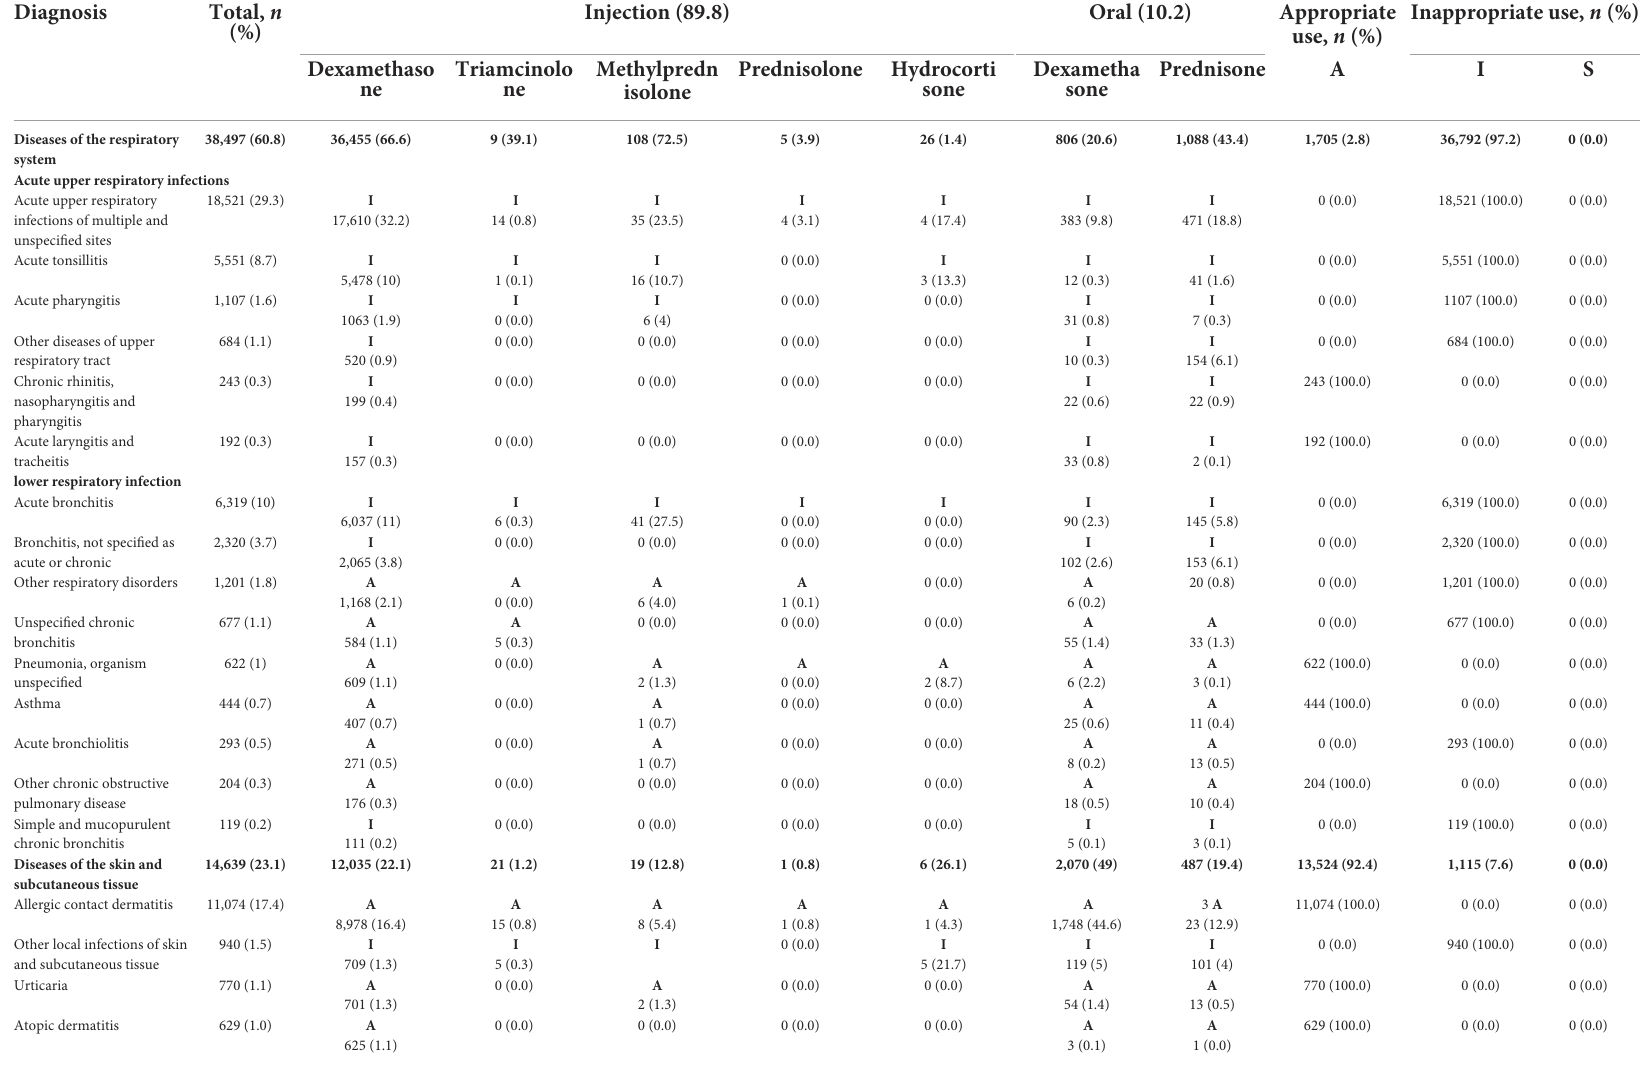
TABLE 1 Prescribing patterns and appropriateness of systemic glucocorticoid prescriptions.